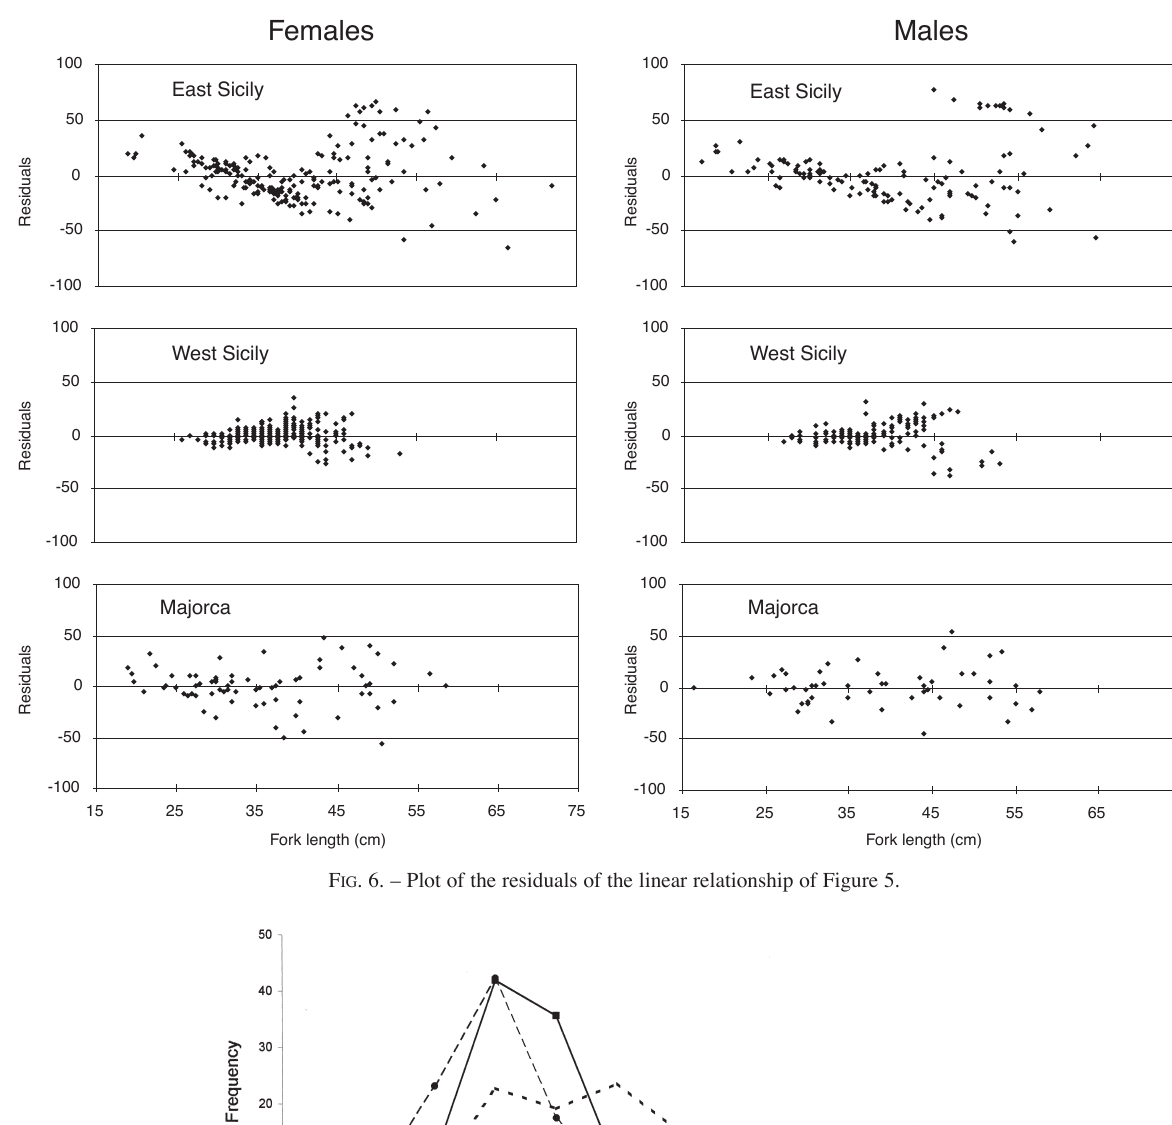
F IG . 6. – Plot of the residuals of the linear relationship of Figure 5.